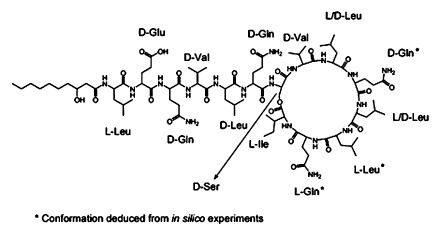
Proposed conformational structure of xantholysin A after Marfey analyses.